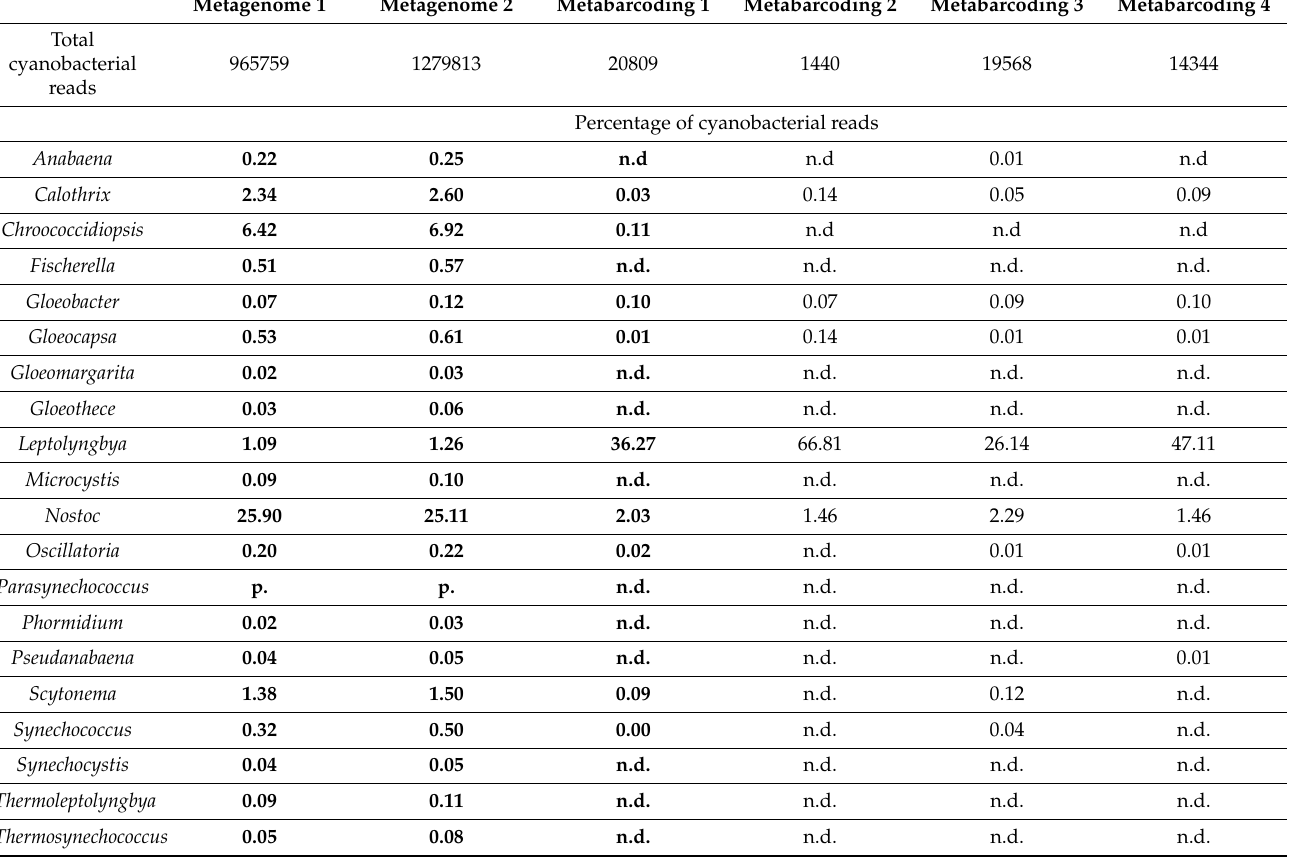
Table 2. Comparison of the abundance of selected cyanobacterial genera in metagenomes and metabarcoding analyses of the Pad2 site. Bold numbers indicate the replicate that was used for metagenomics and metabarcoding. Metagenome 1 Metagenome 2 Metabarcoding 1 Metabarcoding 2 Metabarcoding 3 Metabarcoding 4 20809 1440 19568 14344